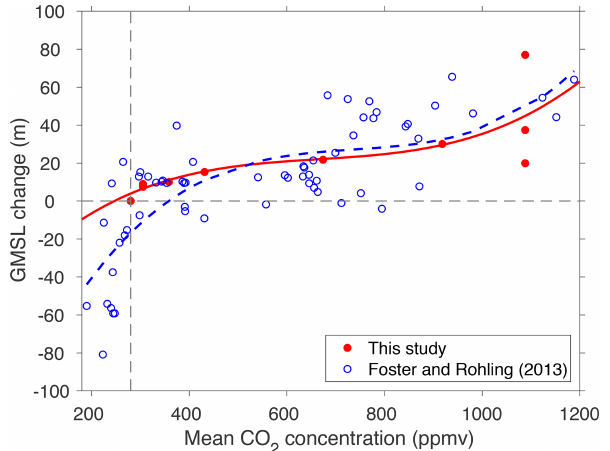
Figure 14. Semi-equilibrated GMSL change projections at 12000CE compared to the geological record of sea-level high stands (Foster and Rohling, 2013) for a given atmospheric CO 2 con- centration. The atmospheric CO 2 concentrations used for the pro- jections of GMSL are averaged over the 10000-year simulation. The horizontal line at 0m GMSL change represents the present-day situation. For scenario MMCP2.6 and MMCP-feedback, the GMSL uncertainty is given by including the experiments with the three dif- ferent climatic parameter sets. The red line is the best fit for the data from our study, while the blue line is the best fit for the Foster and Rohling (2013)